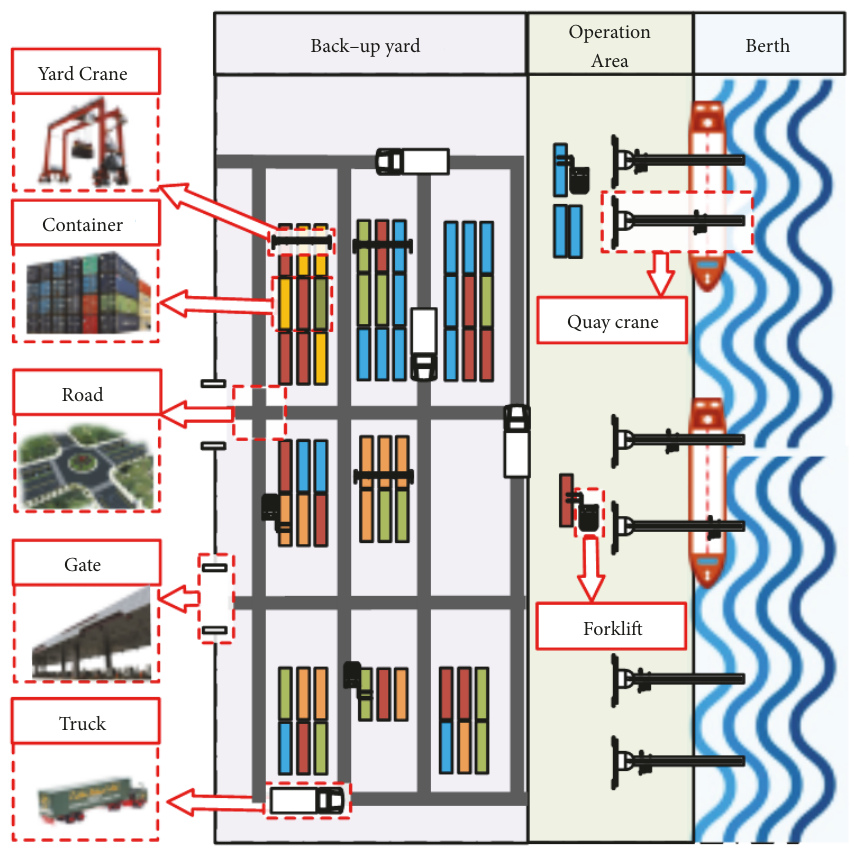
Figure 4: The operating process in a port.